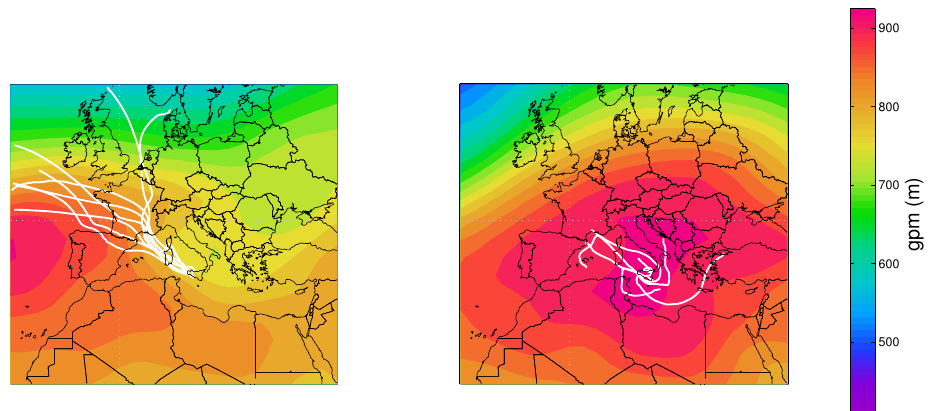
Figure 6. The 5-day back trajectories from 25 November to 1 December superposed onto the average geopotential height at 925 mbar ( left ) and the 5-day isentropic back trajectories from 3 to 9 December superposed onto the average geopotential height at 925 mbar ( right